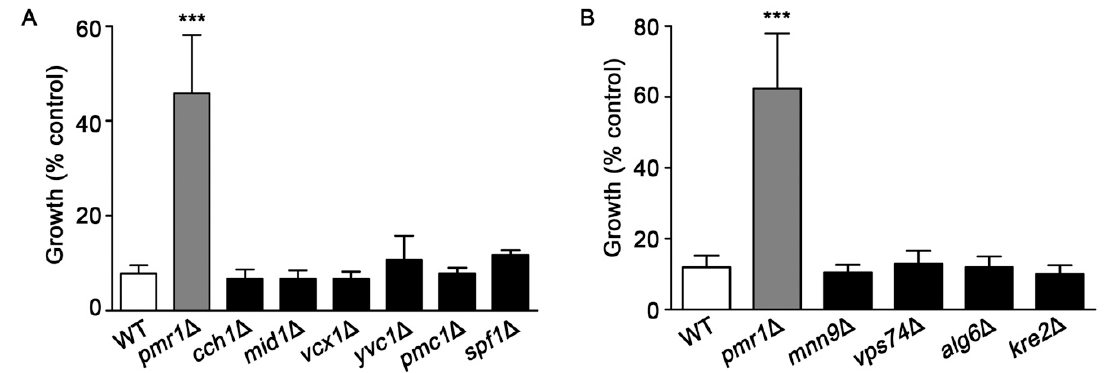
Figure 5. Yeast mutants lacking proteins involved in calcium homeostasis or protein glycosylation are not resistant to artemisinin. WT, pmr1 ∆ , and strains deleted for genes encoding proteins functioning in ( A ) cellular calcium homeostasis; cch1 ∆ , mid1 ∆ , vcx1 ∆ , yvc1 ∆ , pmc1 ∆ , and cod1 ∆ or ( B ) protein glycosylation; mnn9 ∆ , vps74 ∆ , alg6 ∆ , and kre2 ∆ were cultured in SCG media with vehicle or 10 µ M artemisinin. Growth was assessed at 24 h by measuring OD 600 . Results are from three independent experiments; values are the mean + SD. *** P < 0.001 were determined using one-way ANOVA.